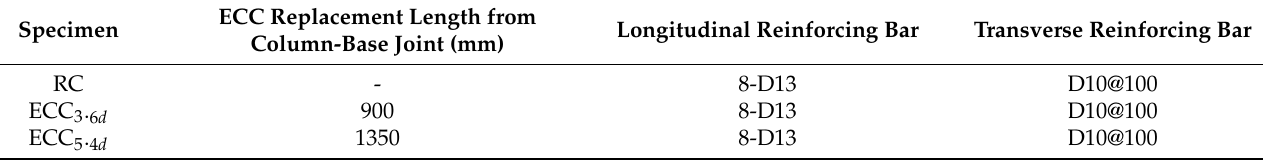
Figure 3. Geometry and dimension details of the column specimen. Table 4. Details of column